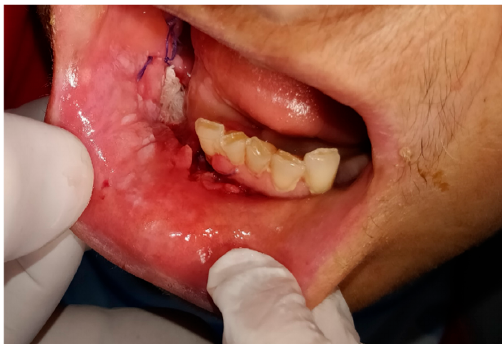
Figure 1. Advanced dressing of the surgical site in patient treated for the cancer of the right alveolar crest during COVID-19 pandemic.